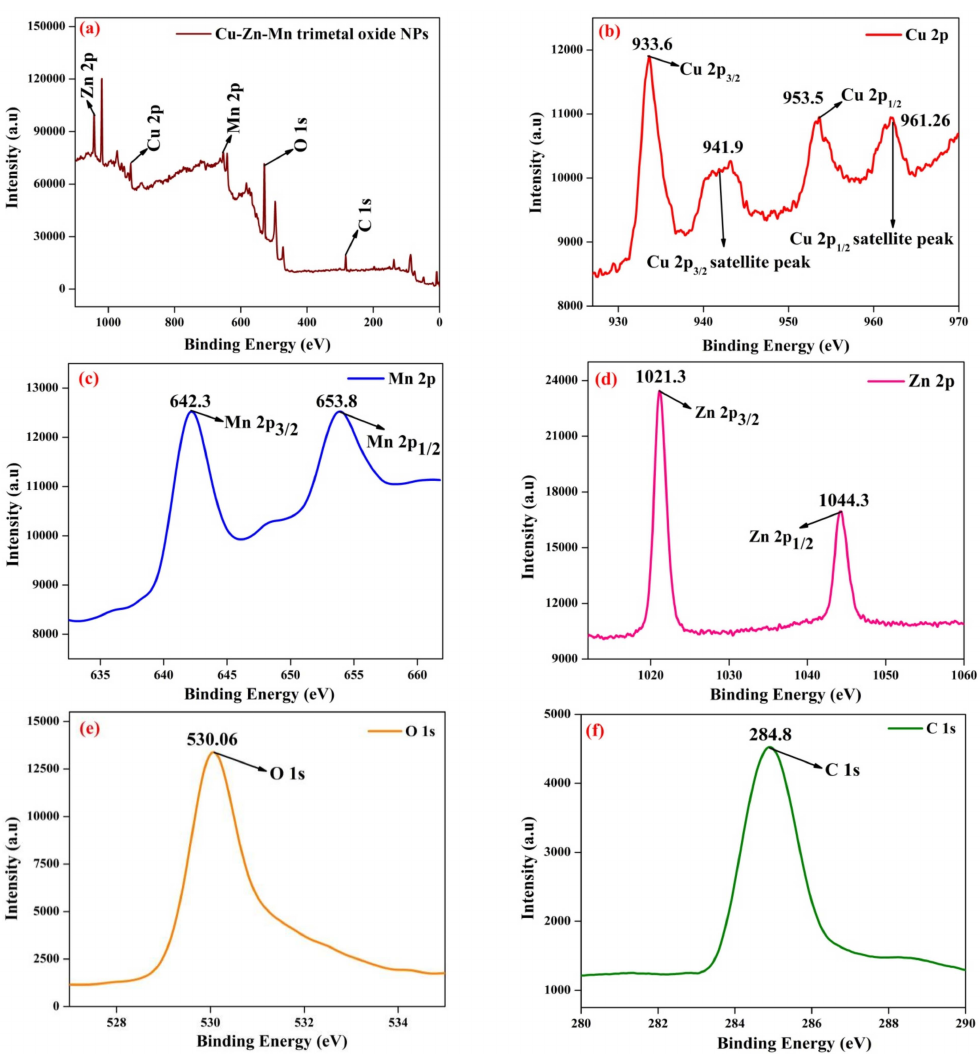
Figure 6. XPS of Cu-Zn-Mn mixed trimetal oxide nanoparticles. ( a ) survey scan of trimetal oxide; ( b ) Cu, ( c ) Mn, ( d ) Zn, ( e ) O, ( f ) C